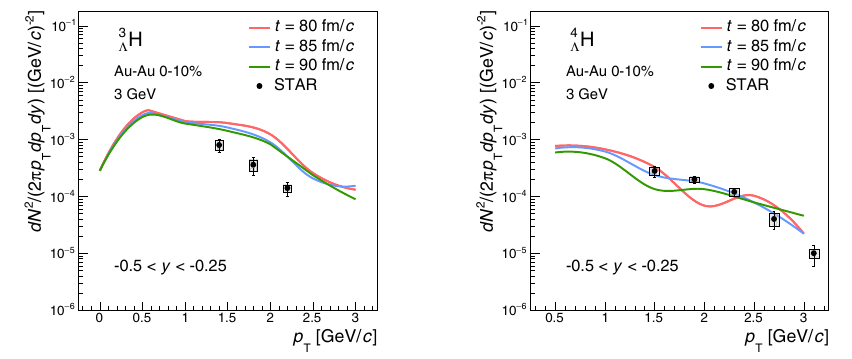
H (left) and 4 H (right) for 0 . 5 < y < 0 . 25 in Λ Λ − −